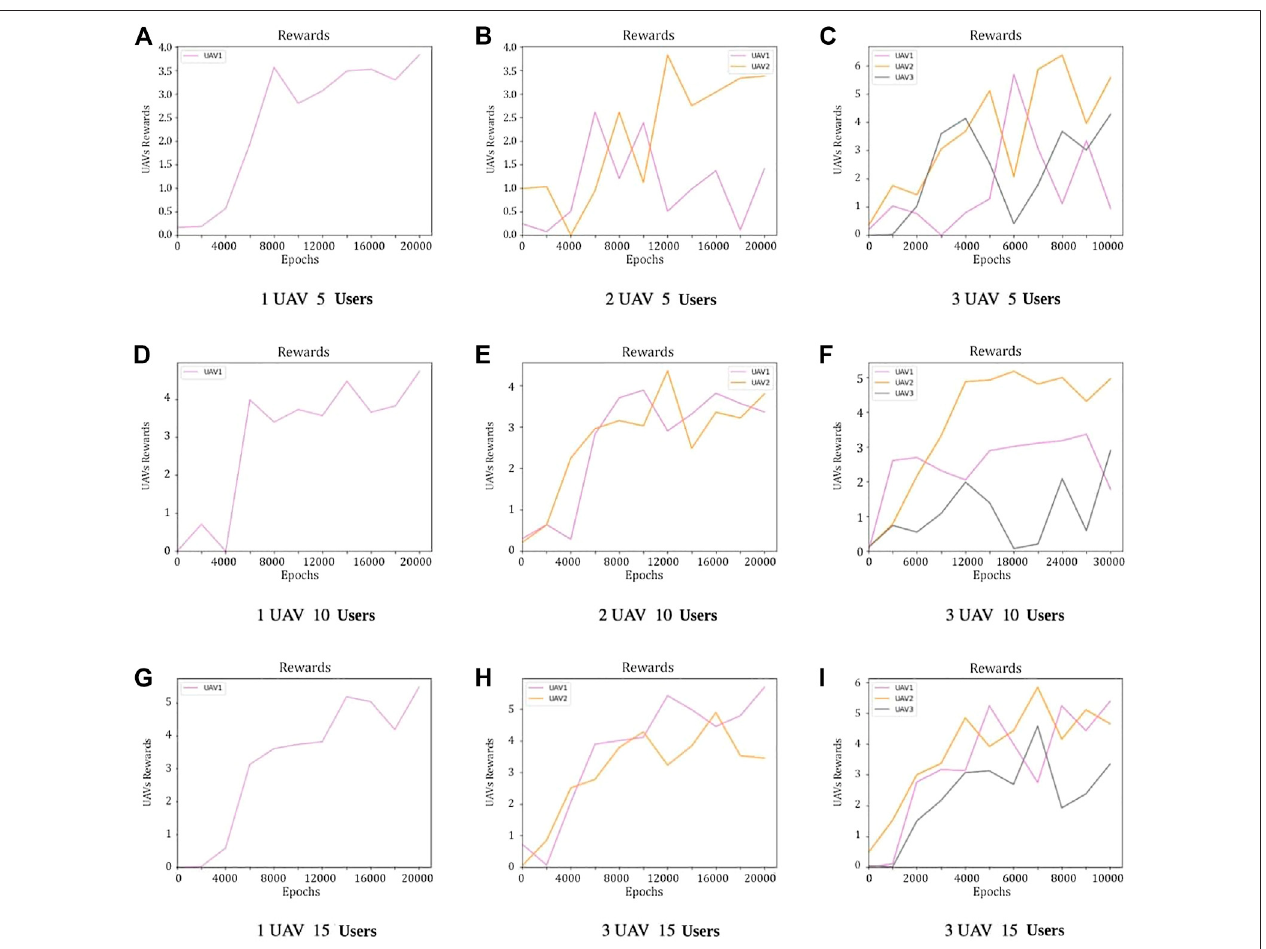
FIGURE 6 | Reward behavior for different numbers of UAVs over the epochs; 5-10-15 users are included in the scenario.